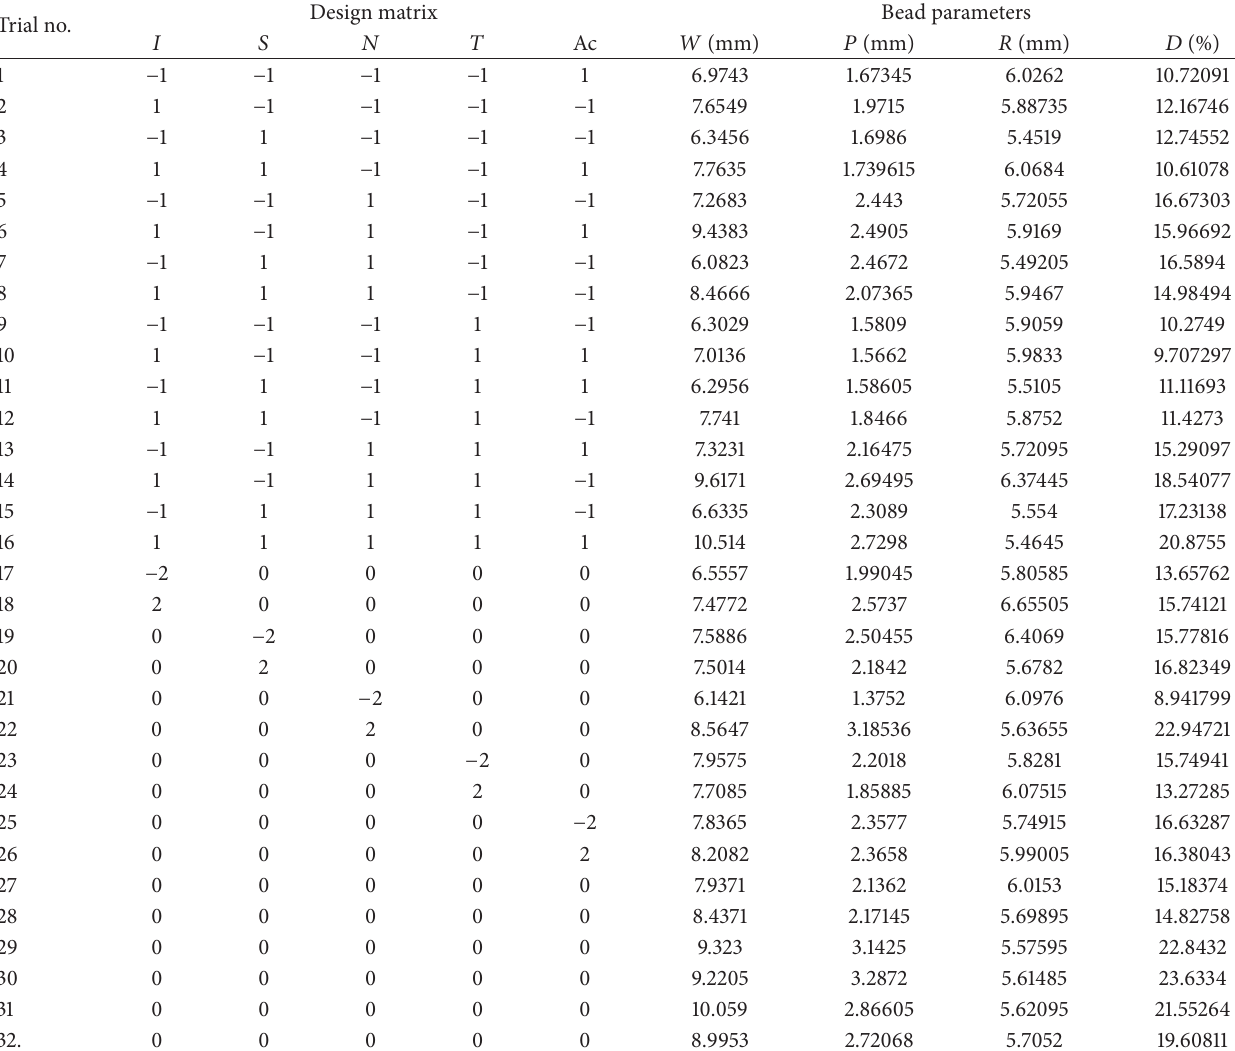
Table 4: Design matrix and observed values of clad bead